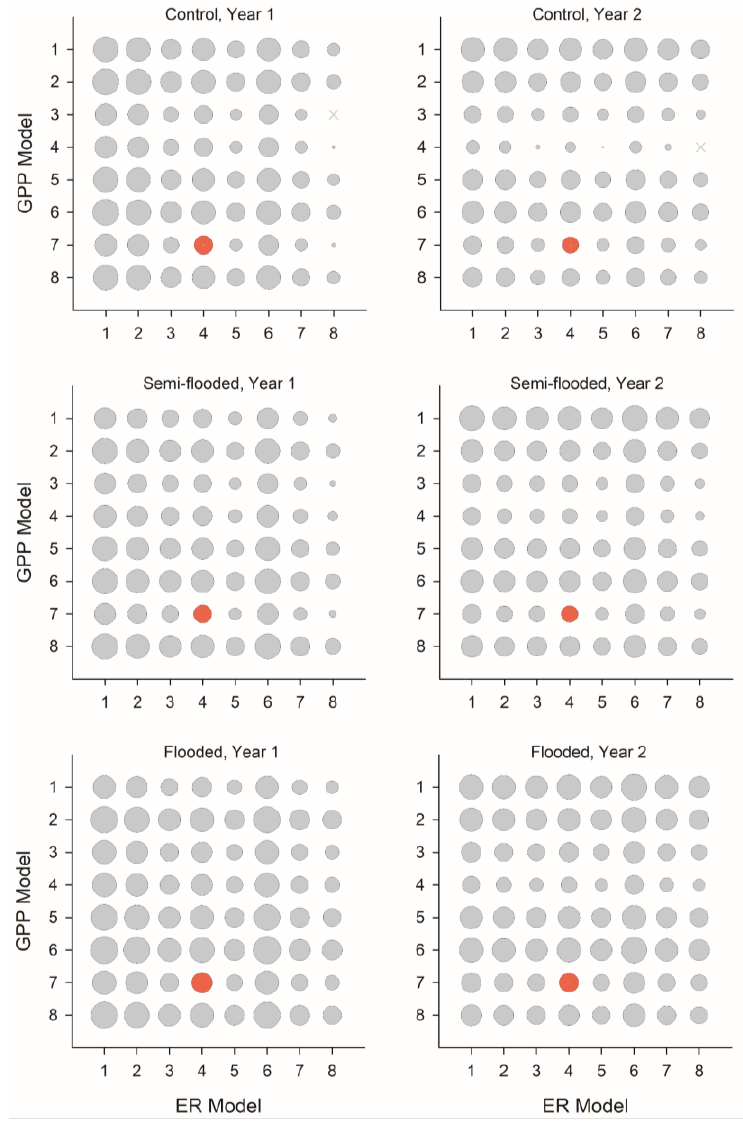
Figure 8. Bubble plot of resulting net ecosystem exchange (NEE) of CO times eight ecosystem respiration (ER) and gross primary production (GPP) models (as depicted in Tables 1 and 2) for individual treatments and study years. Maximum symbol size corresponds to a NEE sink strength of - 935 g CO -C m -2 year -1 . Red symbols show the resulting NEE from the two selected models, ER Model 4 2 and GPP Model 7. Crosses show incidences of small positive NEE